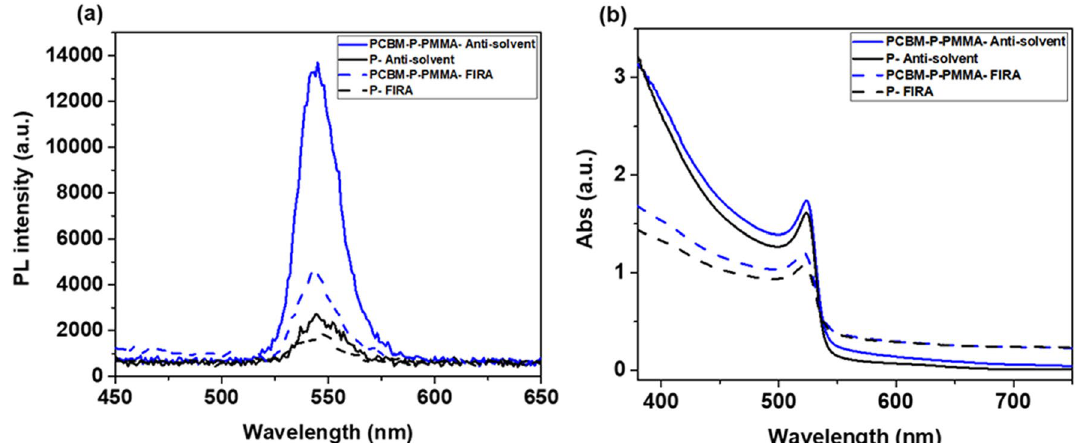
Figure 3. ( a ) Photoluminescence (PL) and ( b ) absorption spectra of cells with the structure FTO/c-TiO 2 /meso- TiO